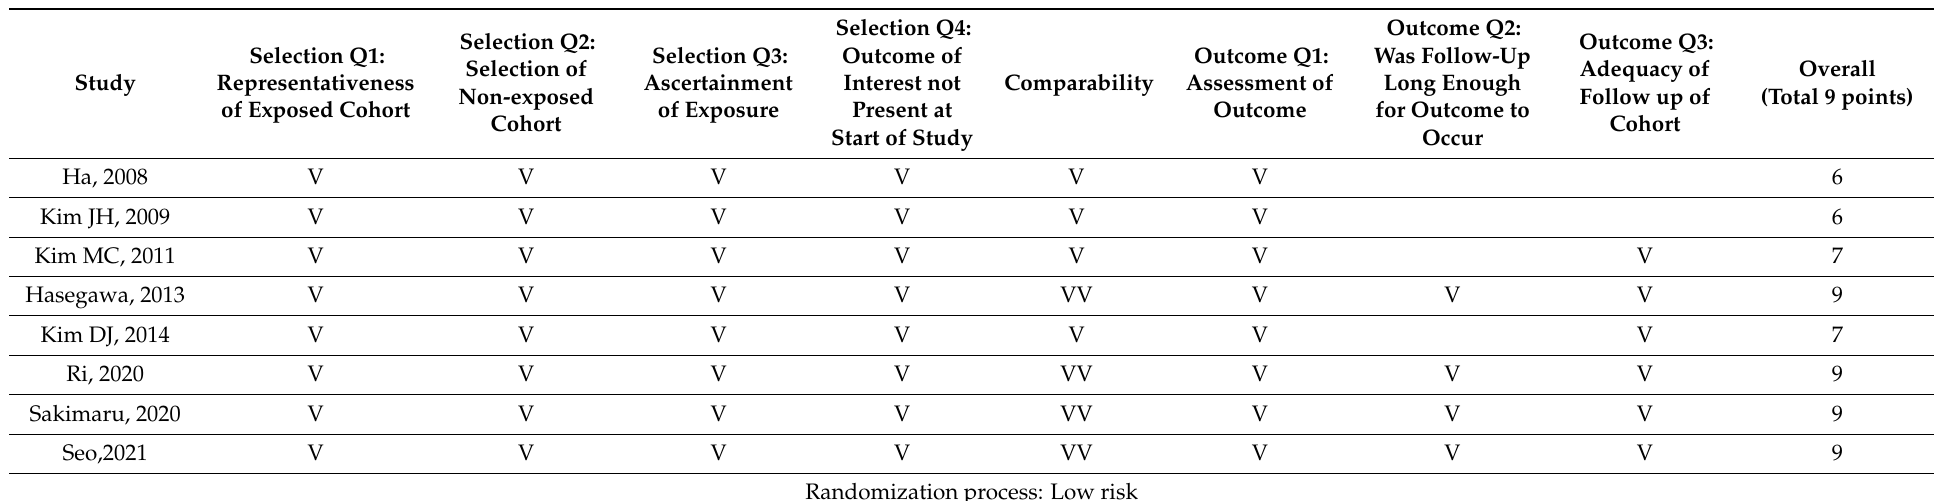
Table 2. Analysis of the methodological quality of the selected